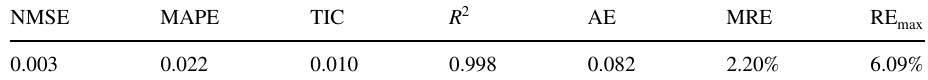
Fig. 7 Comparison of predicted value and original value